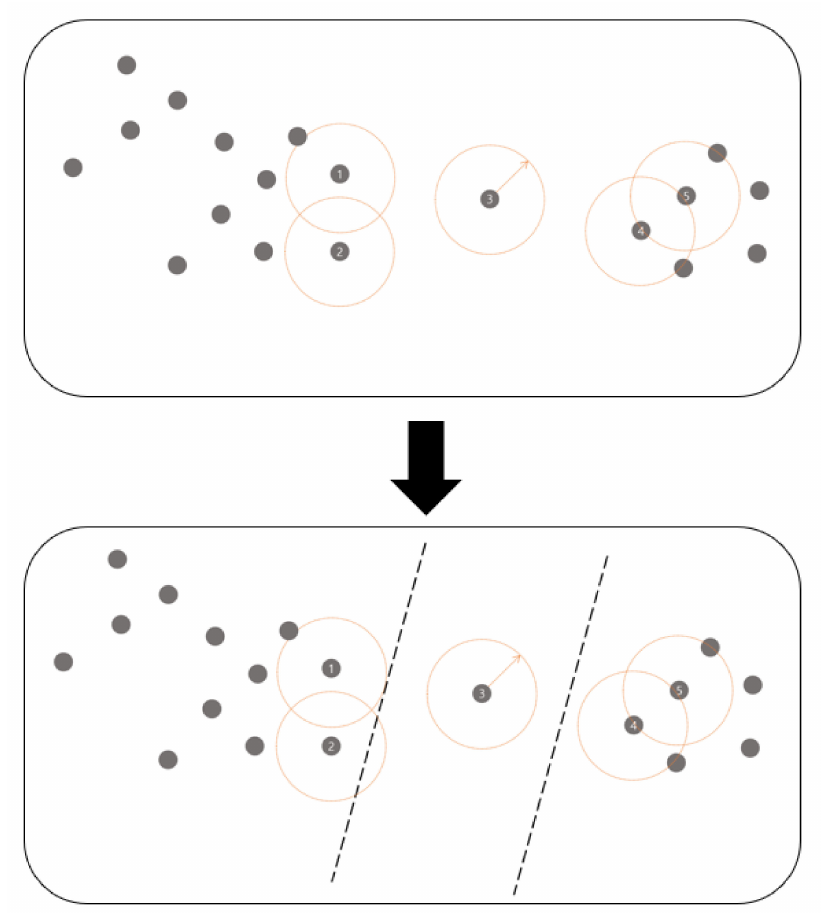
Figure 2. Division based on the communication distance in Step